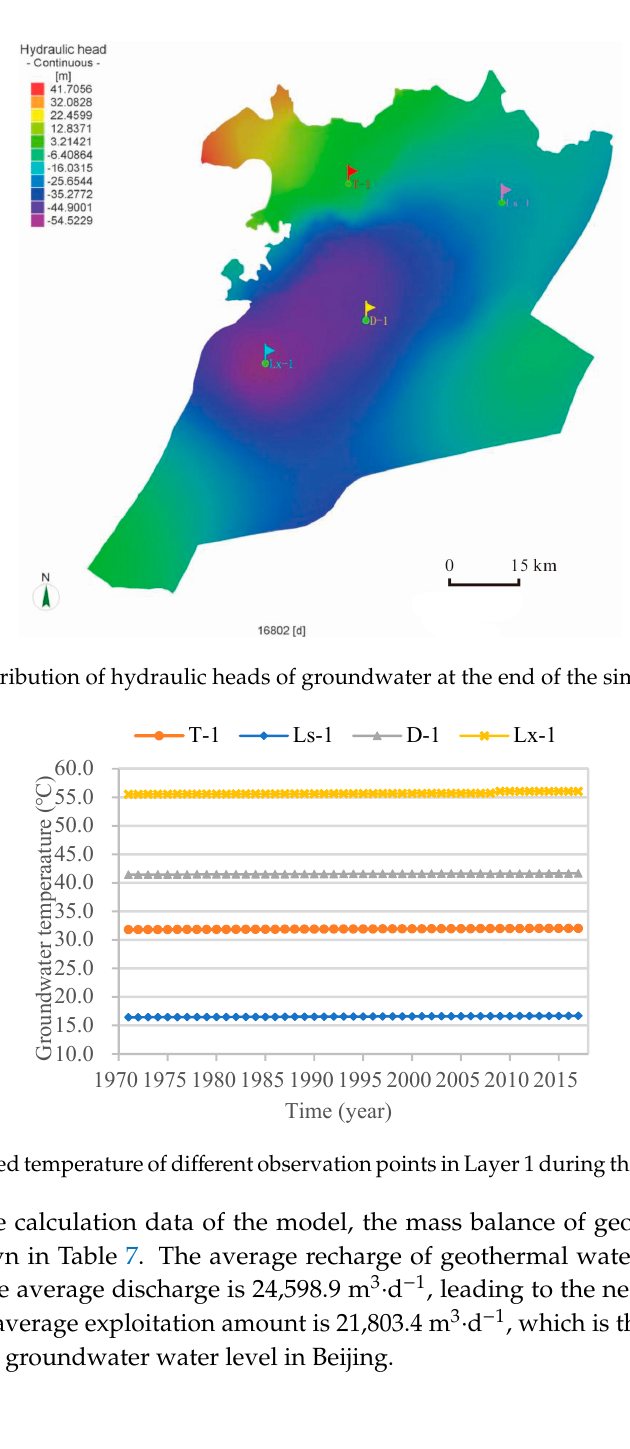
Table 7. Table of average water balance of the study area from 1971 to 2016